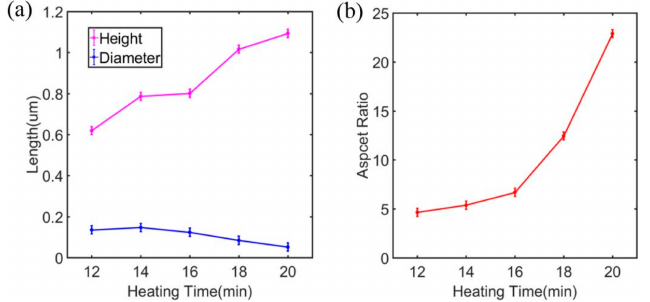
Figure 6. Characterizations of the dimensions of Teflon FEP nanowires with respect to heating time in hot embossing. ( a ) The average values of height and diameter of nanowire structures measured at six different points on each sample; ( b ) The aspect ratios of the nanowires estimated by the average values of the height and diameter over the heating